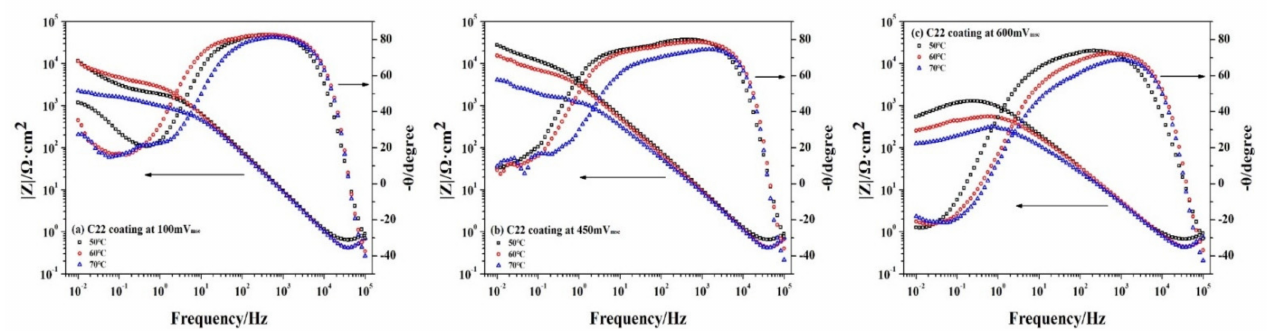
Figure 8. Bode plots for the C22 alloy in 50 wt.% H 2 SO 4 at 100 mV mse ( a ), 450 mV mse ( b ) and 600 mV mse ( c ).